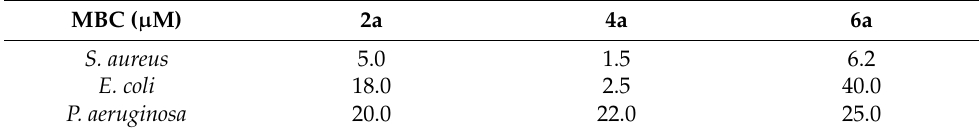
Table 5. Minimum bactericidal concentrations (MBCs) of the cationic porphyrins against S. aureus , E. coli , and P. aeruginosa after 20 h of white light irradiation (4.83 mW/cm 2 , totaling 348 J/cm 2 fluence) at 37 ◦ C. Each MBC is the concentration that inactivated at least 99.9% of bacterial cells, in comparison with the untreated control. Each experiment was performed six times. MBC ( µ M) 2a 4a 6a S.